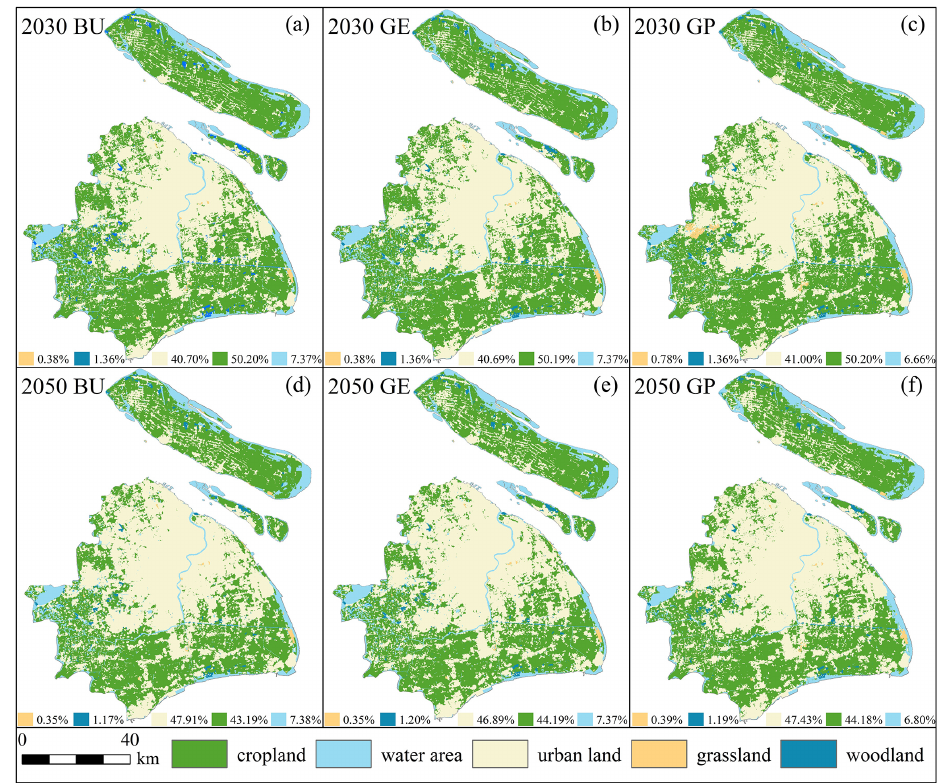
Figure 4. Simulation results of different scenarios in 2030 (a–c) and 2050 (d–f) . Each panel shows the spatial distribution and the proportion of area of different land use types in the simulated scenario. Table 2. Statistics of flood